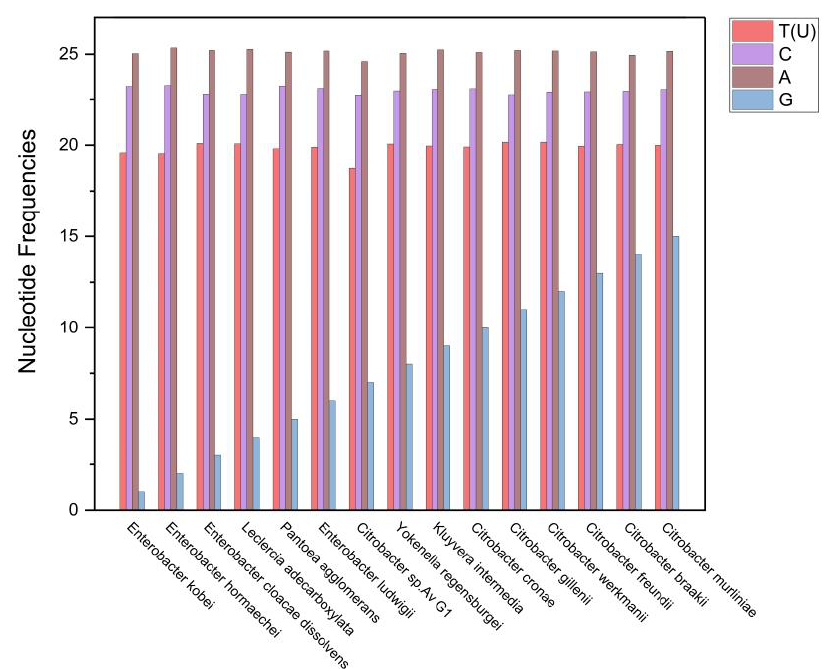
Figure 3. Nucleotide composition of 16S RNA sequences of bacterial strains.